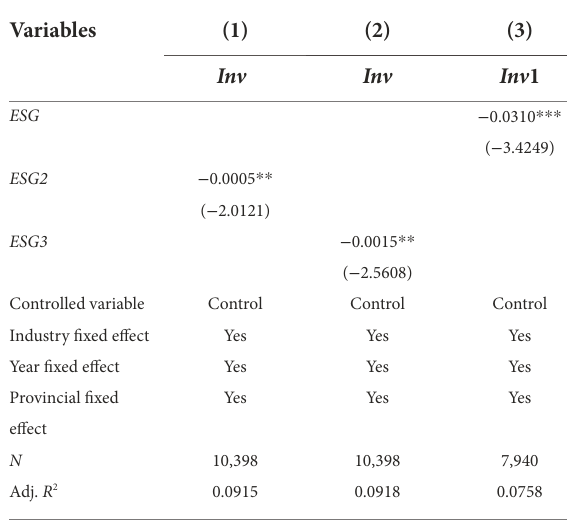
TABLE 6 The effect of ESG performance on investment efficiency. TABLE 7 Robust